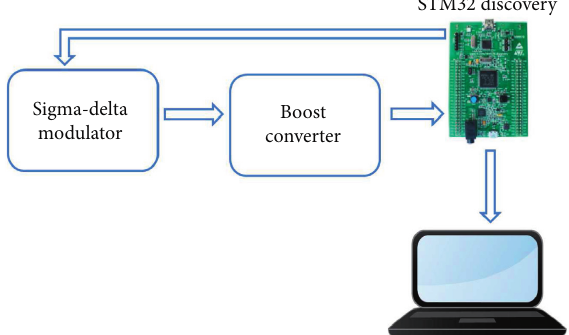
Figure 16: Boost converter prototype scheme for the SSTA